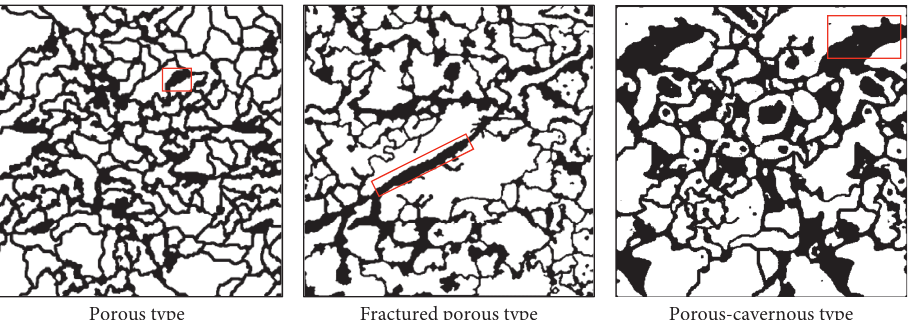
Figure 4: Experimental models of microfluid in different space types of reservoirs (pores, fractures, and caves are marked in the red box). (a) Porous type. (b) Fractured-porous type. (c) Porous-cavernous type.